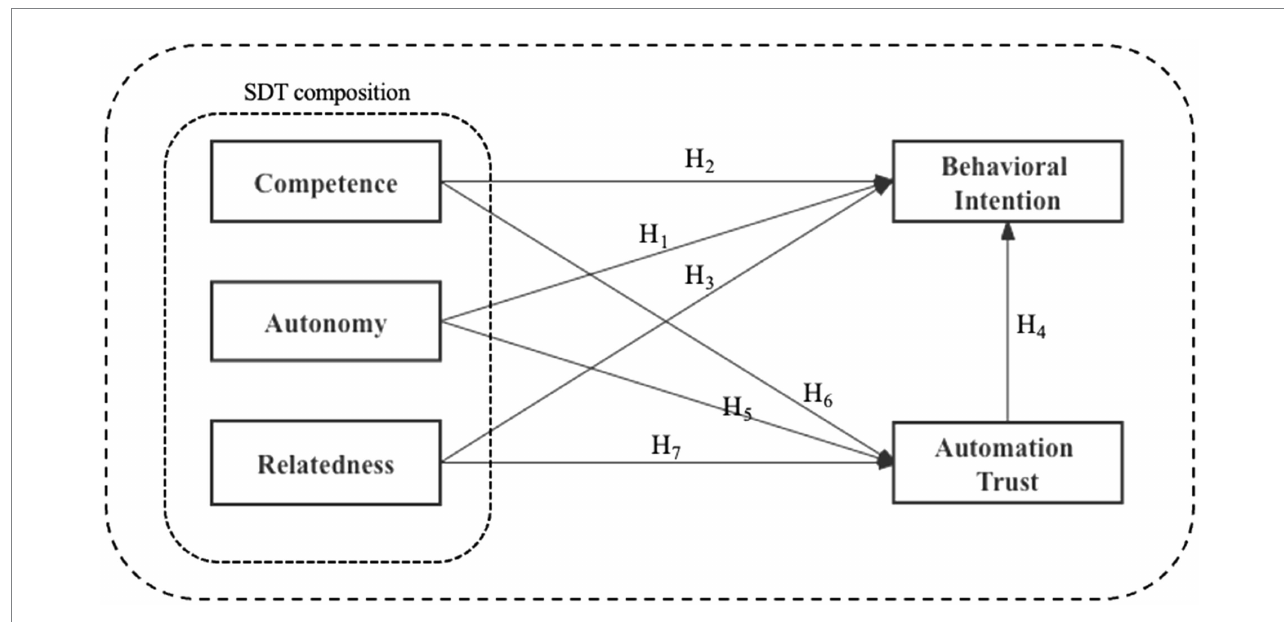
FIGURE 1 Proposed research model.